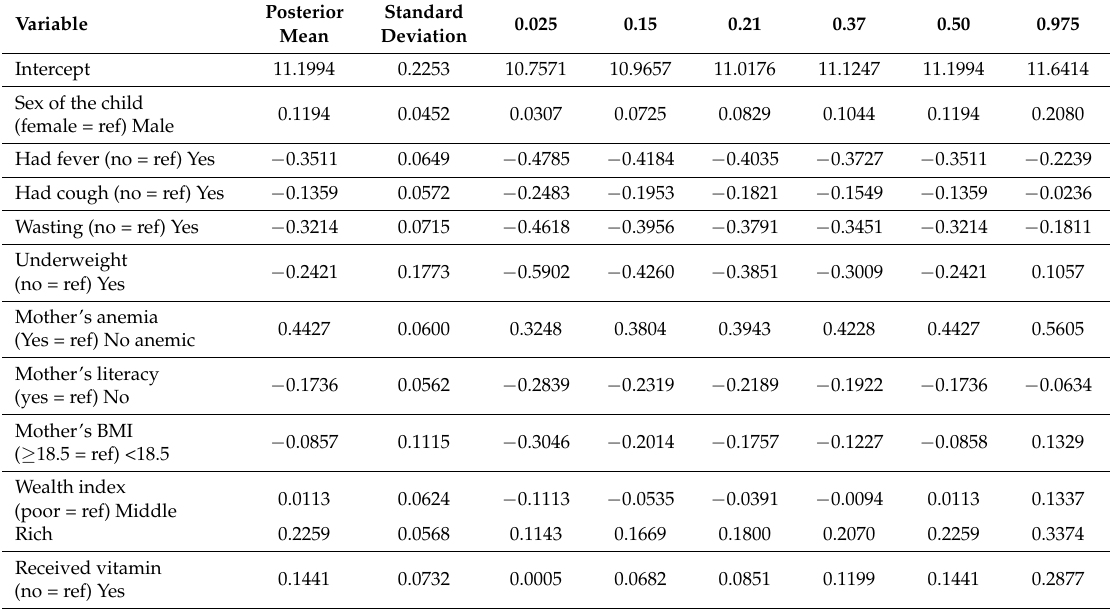
Table 3. Summary of the fixed effects of childhood